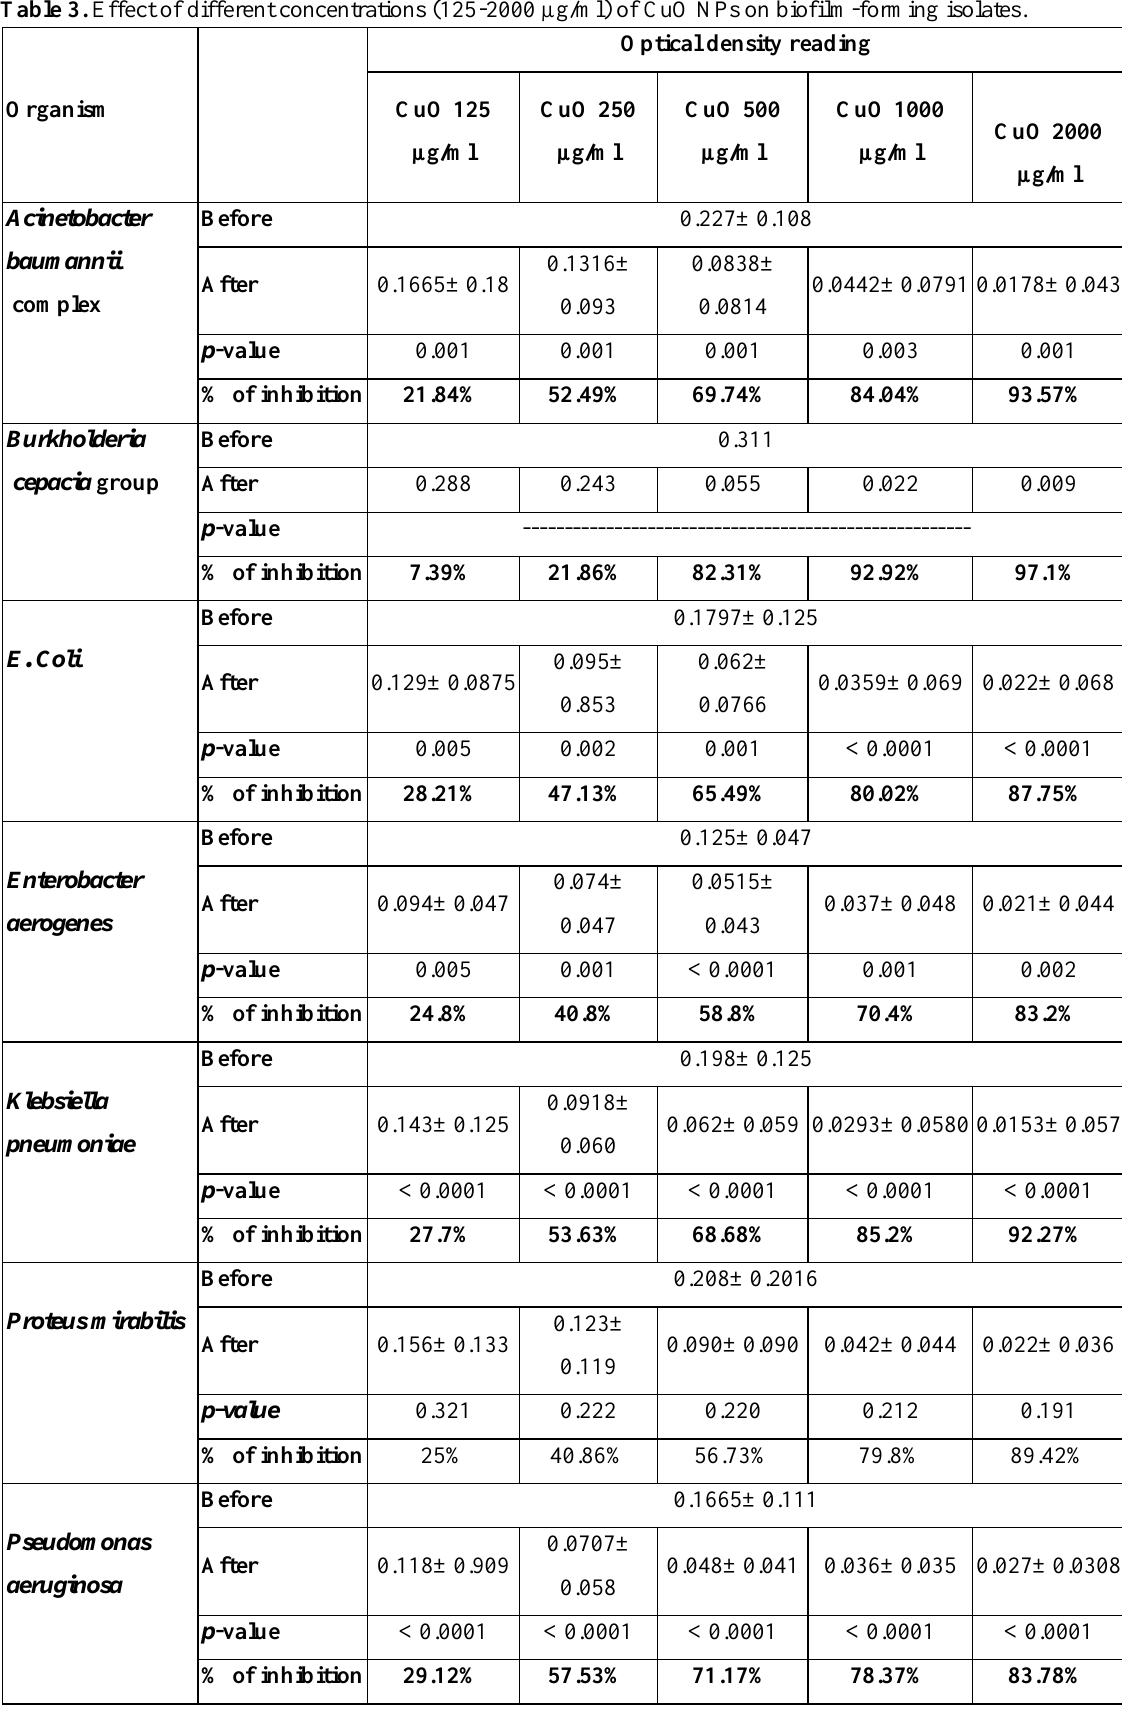
Table 3. Effect of different concentrations (125-2000 µg/ml) of CuO NPs on biofilm-forming isolates.